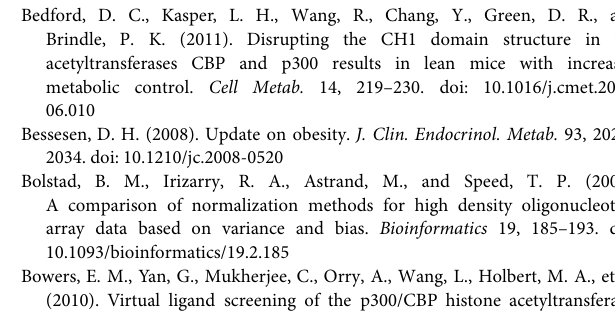
Table S1 | Genes with changes in expression are common between multiple datasets. Sheet 1: Genes with changes in expression are common between RSV and CR in visceral adipose tissue in DIO zebrafish. Sheet 2: Genes with changes in expression are between RSV and CR in subcutaneous adipose tissues of obese humans. Sheet 3: Genes dysregulated in visceral adipose tissues of both female and male DIO zebrafish. Sheet 4: Genes dysregulated in subcutaneous adipose tissues of obese human females and males. Table S2 | Differentially expressed genes in each transcriptome dataset. Sheet 1: Genes regulated by RSV in visceral adipose tissues of female DIO zebrafish. Sheet 2: Genes regulated by CR in visceral adipose tissues of male DIO zebrafish. Sheet 3: Genes regulated by RSV in subcutaneous adipose tissues from obese human males treated with RSV. Sheet 4: Genes regulated by CR in subcutaneous adipose tissues from obese human females. Sheet 5: Genes regulated by CR in subcutaneous adipose tissues from obese human males. Sheet 6: Genes dysregulated in visceral adipose tissues of female DIO zebrafish. Sheet 7: Genes dysregulated in visceral adipose tissues of male DIO zebrafish. Sheet 8: Genes dysregulated in subcutaneous adipose tissues of obese human